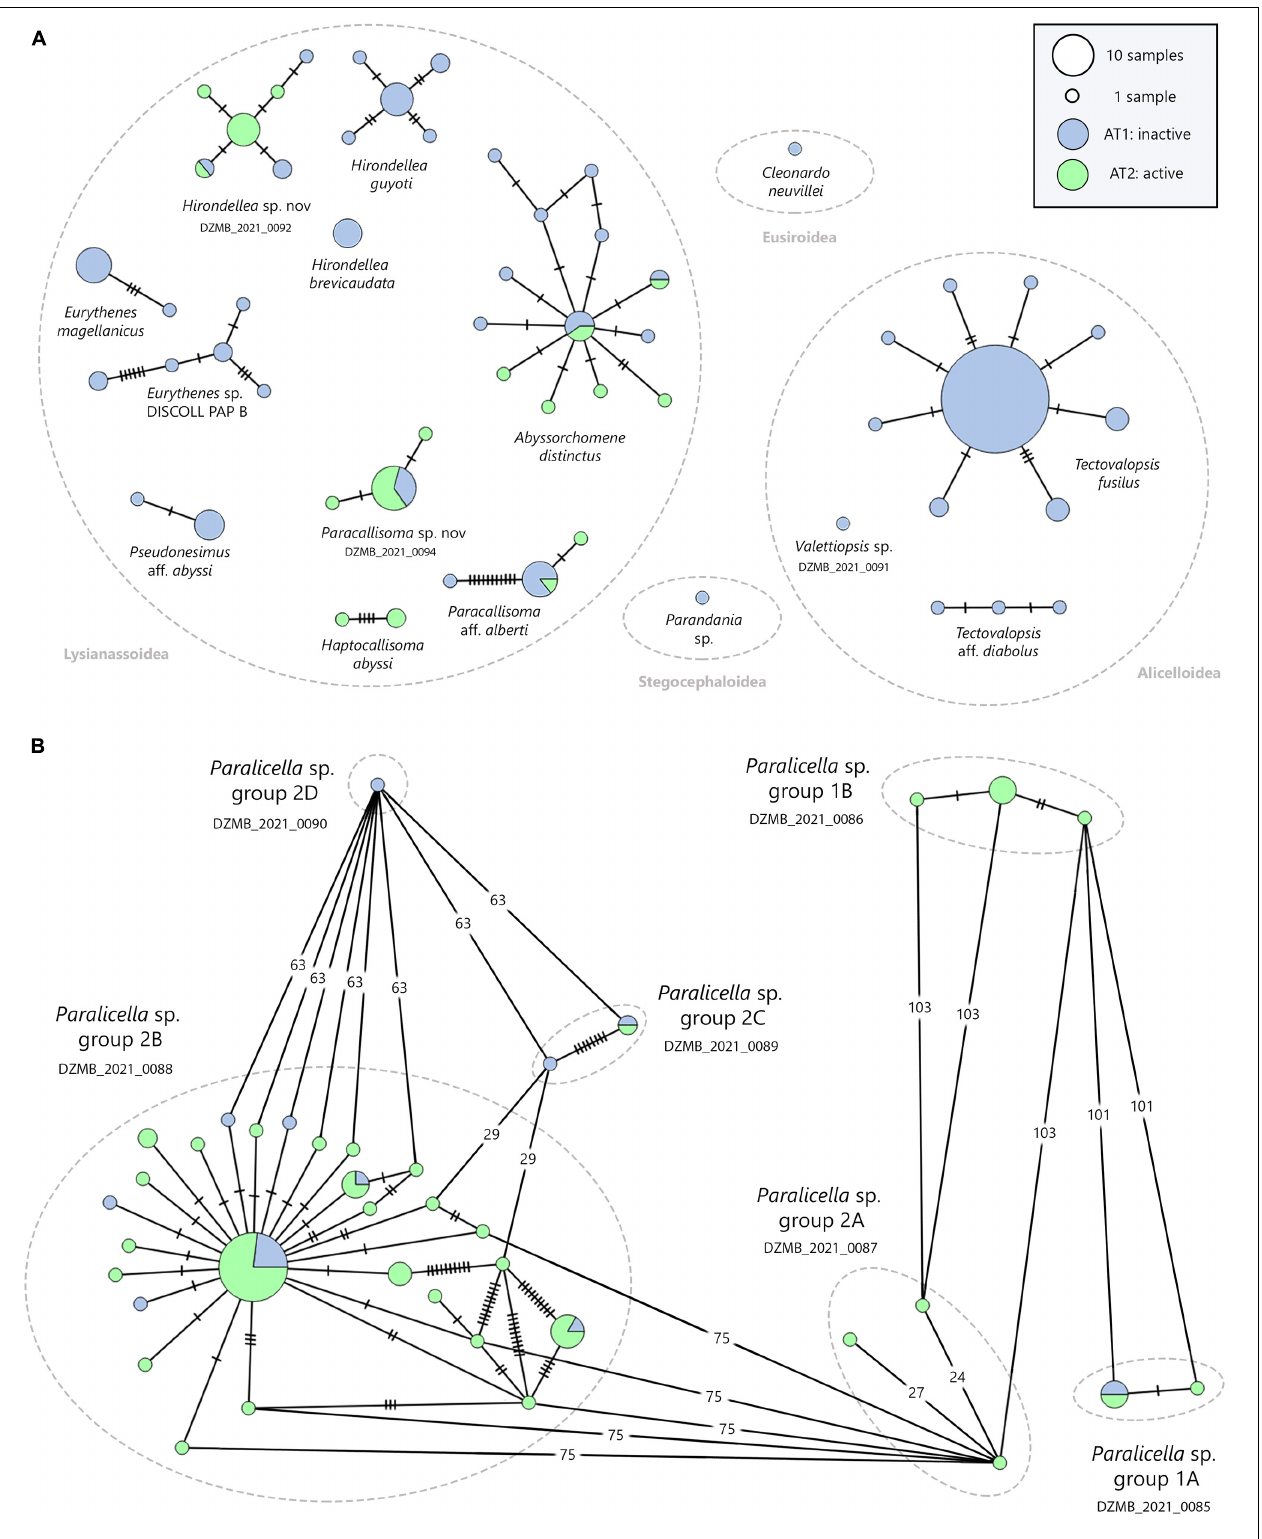
FIGURE 8 | Results of the statistical haplotype network analysis based on the COI data-set (258 individuals). Colors refer to the different sampling localities and the size of each circle is proportional to the number of individuals (see legends). Hatch marks show single substitutions. Minimum spanning networks for (A) Alicelloidea, Eusiroidea, Lysianassoidea and Stegocephaloidea. (B) Paralicella ; differentiated into six groups. Mutations ( n > 10) are presented as numbers.